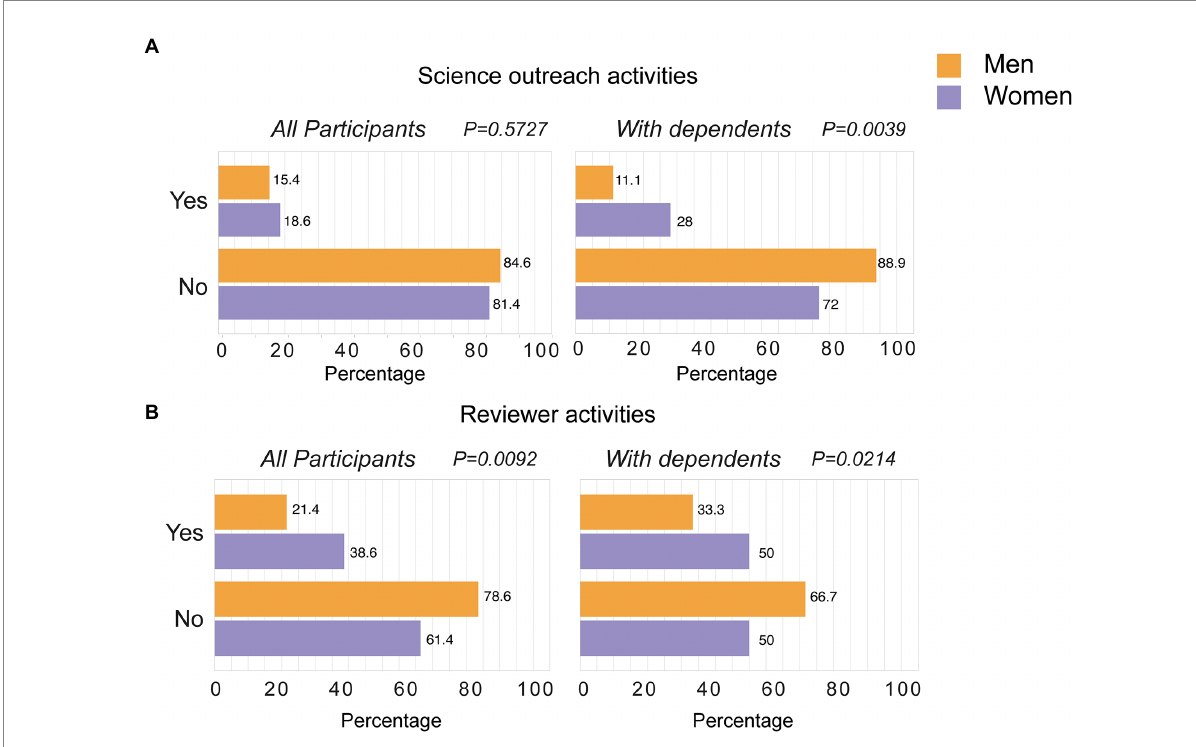
FIGURE 2 Impact of COVID-19 lockdowns in the participation on service work-oriented scientific tasks. (A,B) The indicated activities were analyzed in the subset of participants performing professional research activities ( n = 59; left) and only those with professional research activities and children or dependents at care ( n = 35; right). Numbers in each bar show the percentage of men (orange bars), and women (purple bars) who did (Yes) or not (No) in each of the activities analyzed. Statistical differences in the distributions between men and women were analyzed with Fisher’s exact